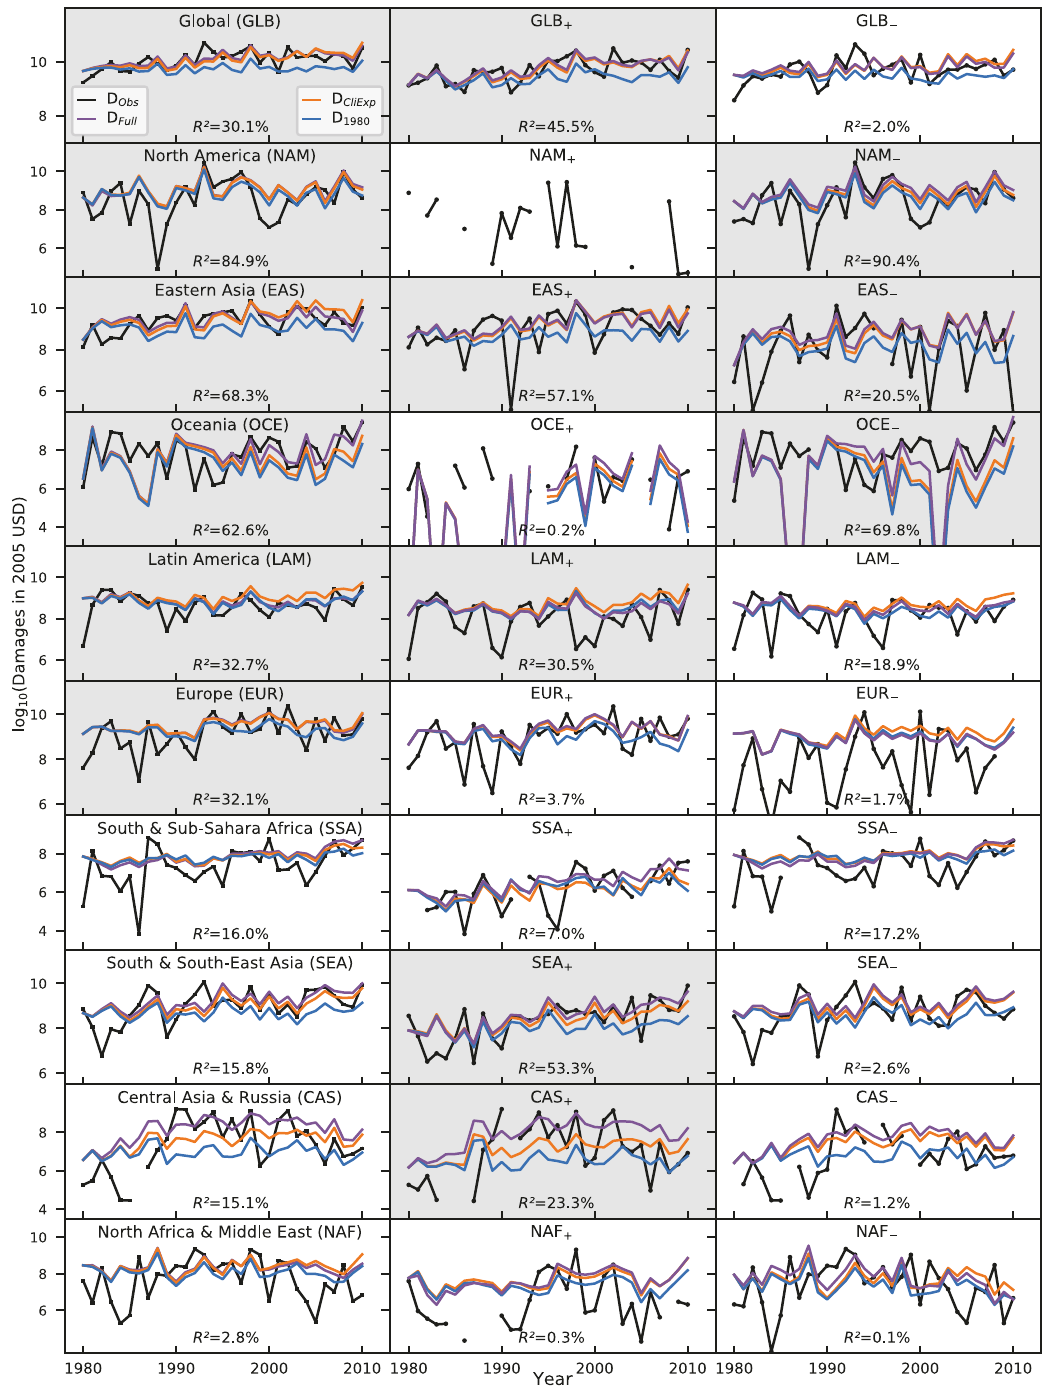
Fig. 2 Observed and modeled time series of river fl ood damages (1980 – 2010). Time series of observed damages from the NatCatService database 1 ( D Obs , black) as well as modeled damages (multi-model median) when accounting for changes in (i) climate only (constant 1980 socio-economic conditions, D 1980 , blue), (ii) climate and exposure ( D CliExp , orange) keeping vulnerability at 1980 conditions, and (iii) in climate, exposure, and vulnerability ( D Full , purple) for the nine world regions (left panel), as well as their subregions with homogeneous positive and negative trends in river discharge (middle and right panels) (cf. Fig. 1). Time series indicating the GHM-spread are provided in Supplementary Fig. 5. Explained variances R 2 are derived from the Pearson correlation coef fi cients between damages D Full and D Obs . Gray background colors highlight the regions where the explained variance of the full model is higher than